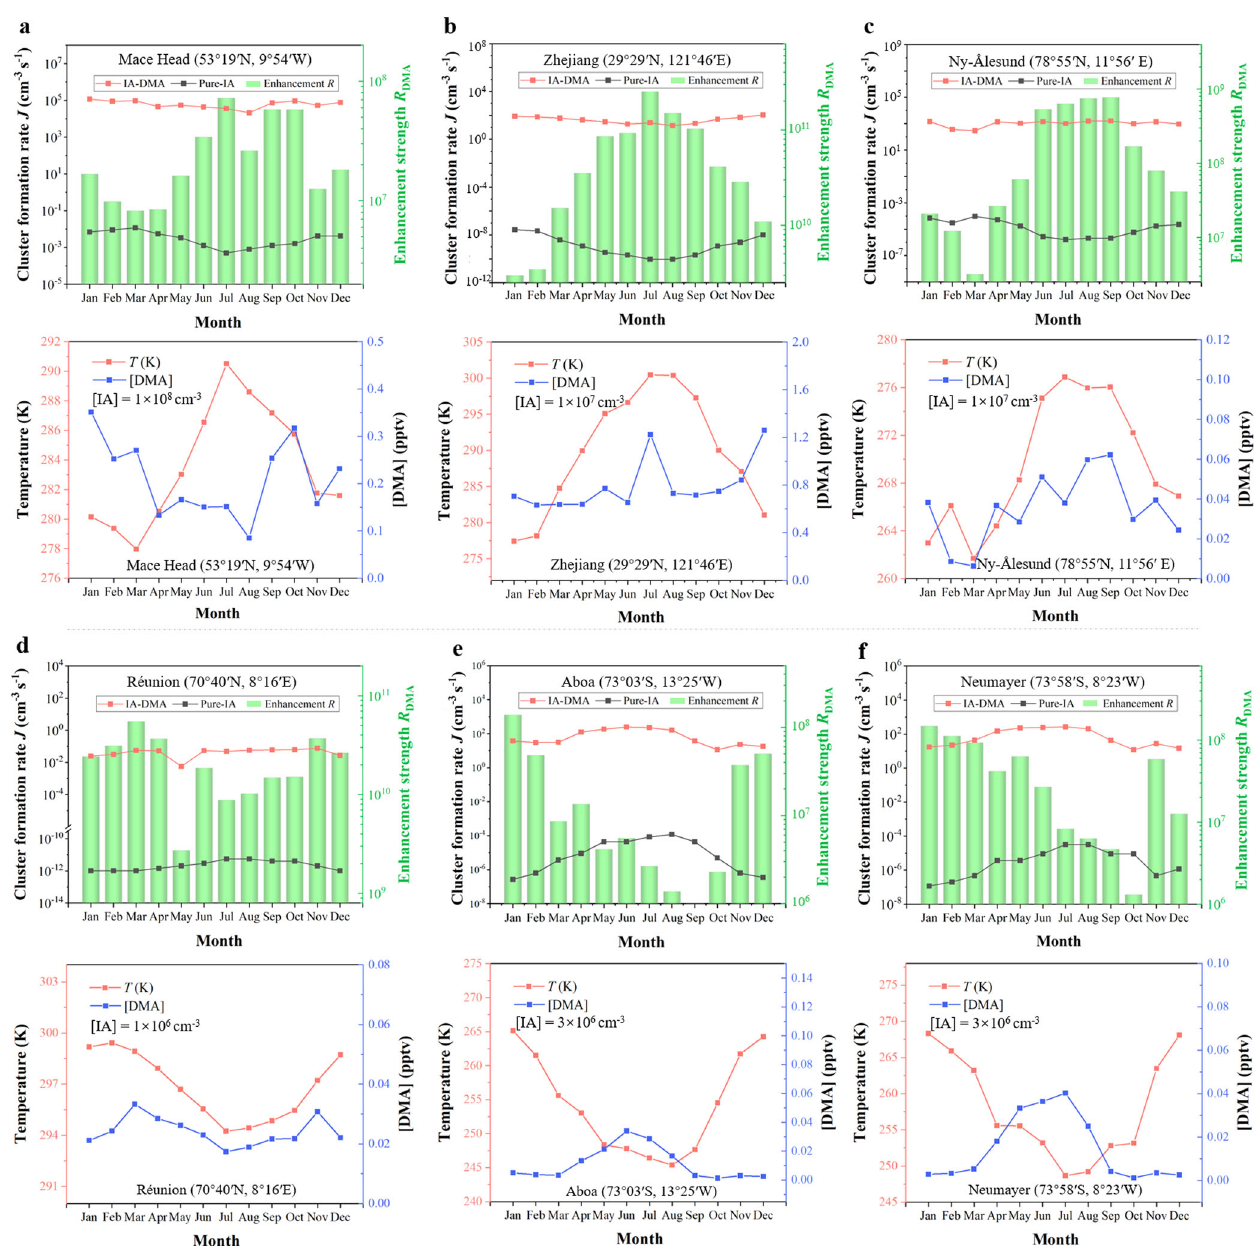
Fig. 6 The IA-DMA nucleation in different regions. Cluster formation rates ( J , cm − 3 s − 1 ) shown in orange squares (IA-DMA) and black squares (pure-IA) and the enhancement R by DMA (Green pillars) at varying atmospheric conditions in different months of a Mace Head, b